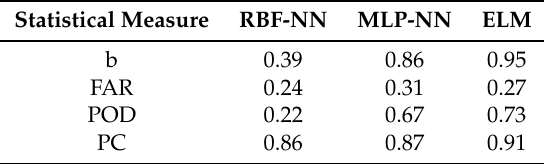
Table 4. The mean predicting performance of the exceedance for the air pollutant PM 2.5 for RBF-NN, MLP-NN, and ELM. b: bias; POD: probability of detection; PC: the percentage correct; FAR: false alarm rate. Statistical Measure